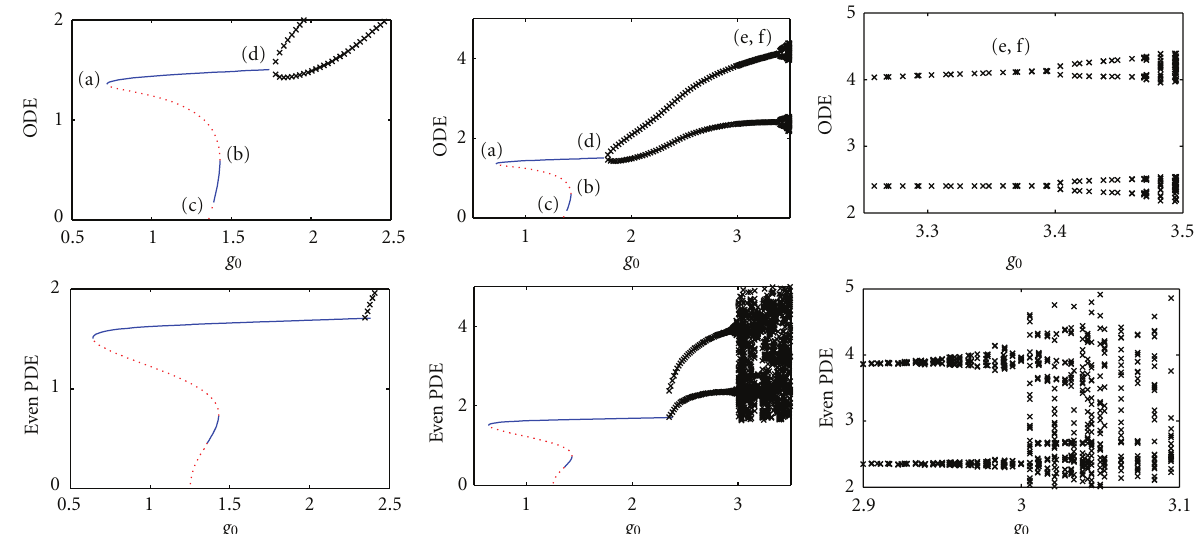
Figure 13: Top: the bifurcation diagram of energy ( L 2 norm) versus g 0 for the multi-pulse transition in the POD model. Bottom: the bifurcation diagram of the multi-pulse transition of the WGAML model. The di ff erent plots show the same diagram with emphasis on di ff erent regions of the transition. For the stationary solutions, emphasized on the left, linearly unstable regions are dashed (red) lines while linearly stable regions are solid (blue) lines. Stationary solutions that were not computed explicitly are denoted with dots. For the periodic solutions, the x s are the local extrema of the energy ( L 2